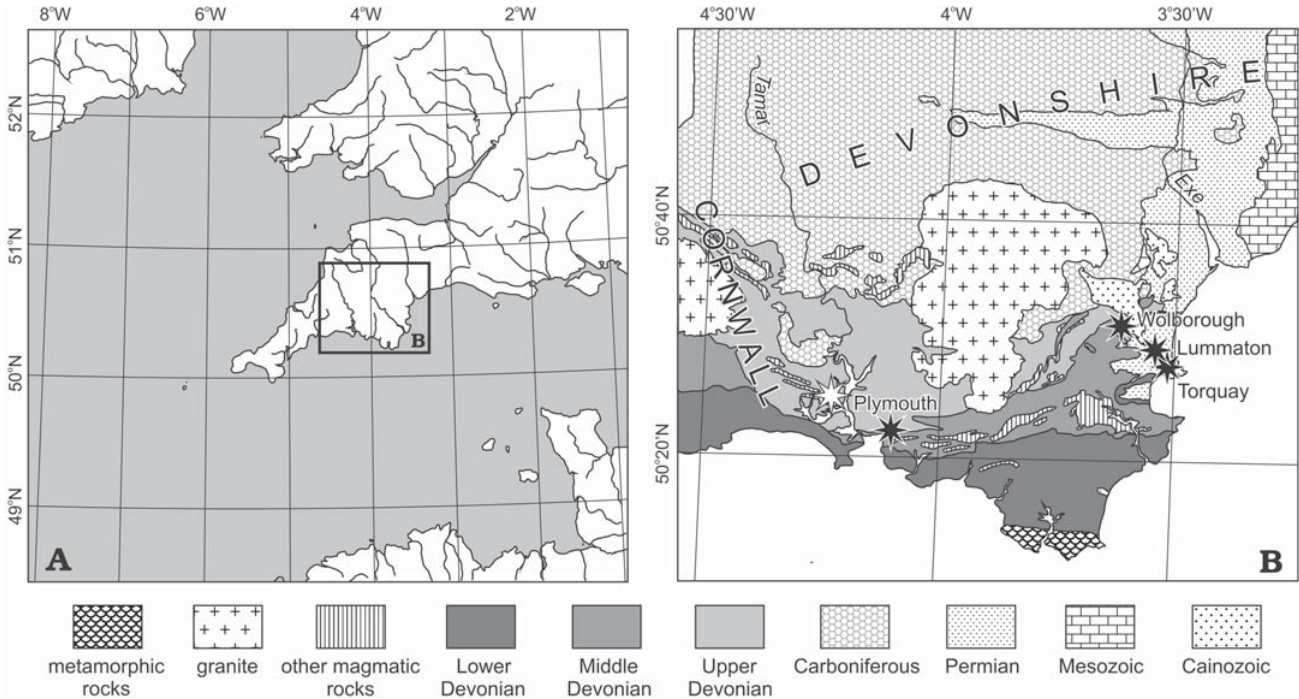
Fig. 1. A . Geographical location of the study area in north-western Europe. B . Geological map of eastern Cornwall and southern Devon (Devonian after House and Selwood 1966, otherwise simplified and modified after British Geological Survey 1957). Black asterisks show fossil localities mentioned in the text. The white asterisk shows the presumed position of “Port Stephens” (see text for further